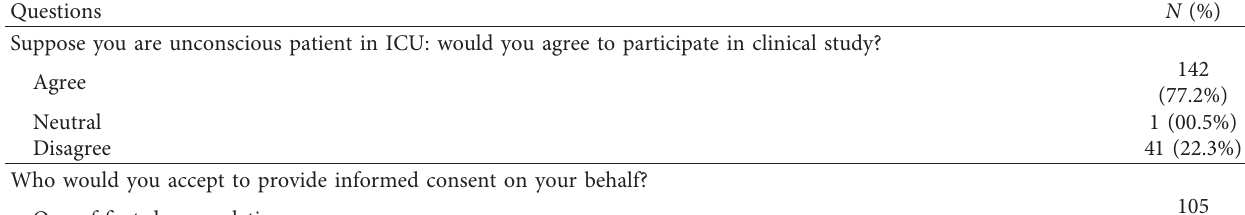
Table 4: Attitude of the relatives toward participating in clinical research.